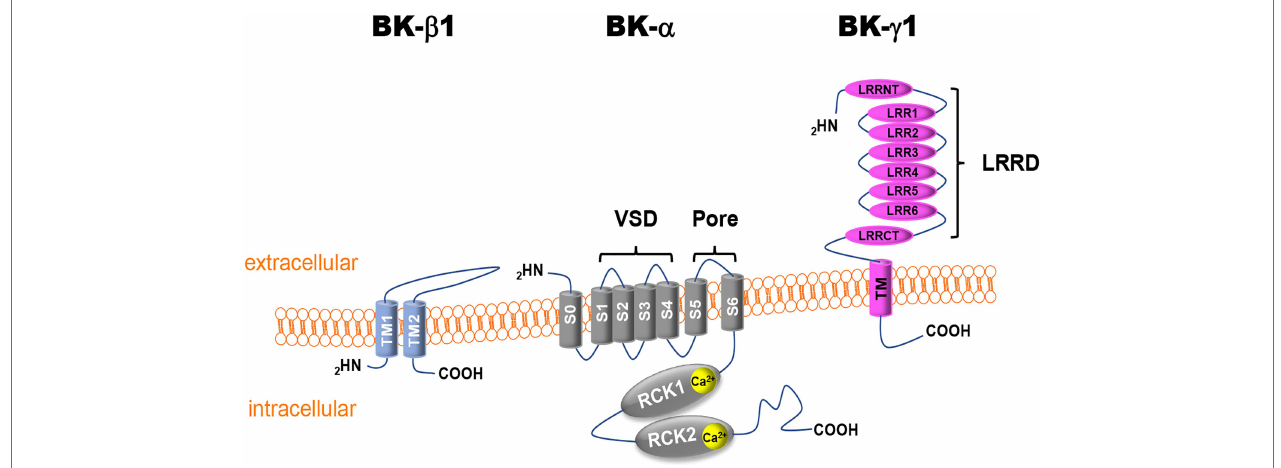
FIGURE 1 | Schematic illustration of vascular Ca 2+ -activated K + (BK) channel subunits. BK- α , BK channel α -subunit; BK- β 1, BK channel β 1-subunit; BK- γ 1, BK channel γ 1-subunit; S or TM, transmembrane domain segment; VDS, voltage-sensor domain; RCK, regulator of K + conductance; LRR, leucine-rich repeat; LRRD, leucine-rich repeat domain; LRRCT, leucine-rich repeat C-terminus; LRRNT, leucine-rich repeat N-terminus; COOH, C-terminus; and NH 2 ,